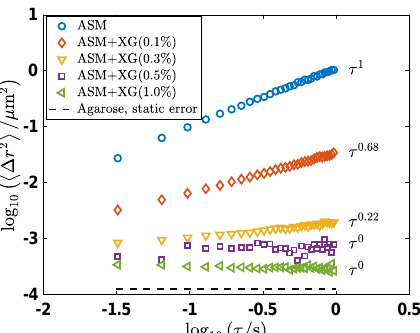
Figure 8: MSD of particles that were suspended in ASM with differ- ent concentrations of XG. The slope of MSD shows that the ASM is purely viscous (︀ MSD ∼ τ 1 )︀ . With an increase in concentration of XG, the mixture becomes elastically dominated, and eventually, it becomes a pure solid (︀ MSD ∼ τ 0 )︀ . The agarose that was used to characterize the static error of the experimental system is shown for comparison of the cage